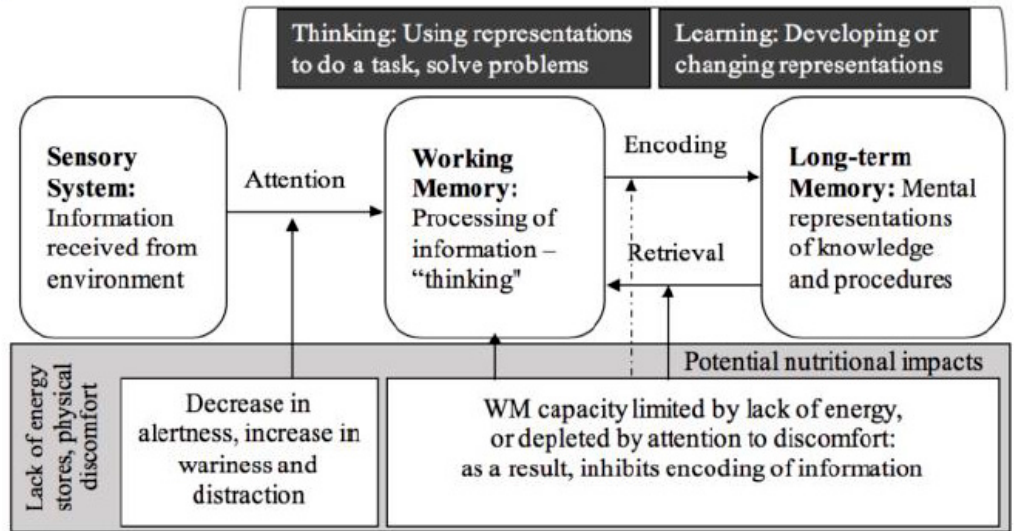
Figure 2. An example of the process involved in learning and potential impacts of nutrition, based on Information Processing Theory. The process of learning is a complex construct that can be described as a series of engagement in processing and information-storing / memory systems that ultimately result in knowledge. One of the most basic conditions for a child to be able to complete these tasks is having the necessary energy and no inhibiting factors of discomfort (e.g., hunger, fatigue). If conditions are not optimal, the child experiences lower levels of alertness, or wariness, thus decreases attention to any input from the environment. Thus, WM capacity will be restricted, limiting what information is eventually encoded and retained in long-term memory, from where it can be retrieved at a later time.